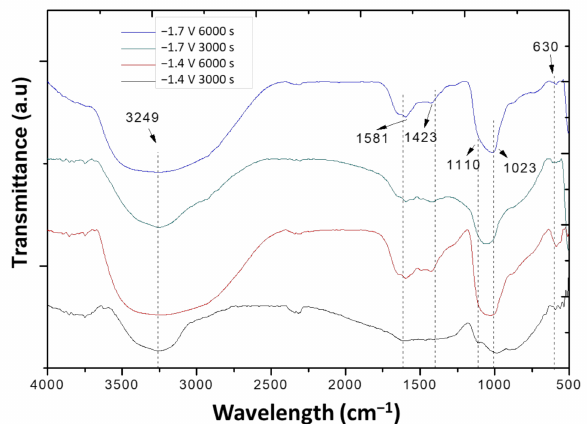
Figure 9. FTIR spectra of HAp deposition on (Ta/TaN)/SS at different potential and time. The SEM images of the layer electrodeposited on (Ta/TaN)/SS (Figure 10) show similar morphologies for both potentials ( − 1.4 V and − 1.7 V), with a formation of agglomerates and larger formation of the product for longer periods (6000 s); this is in good agreement with the measured mass deposition (Table 2). The Ca/P was determined by EDS, indicating that, for 6000 s, this ratio corresponded to non-stoichiometric HAp (Table